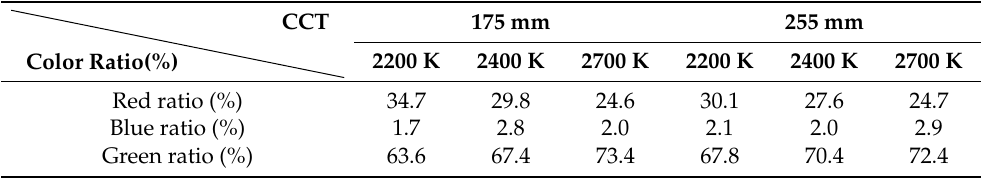
Figure 6. Chromaticity coordinate: ( a ) 175-mm filament; ( b ) 255-mm filament.